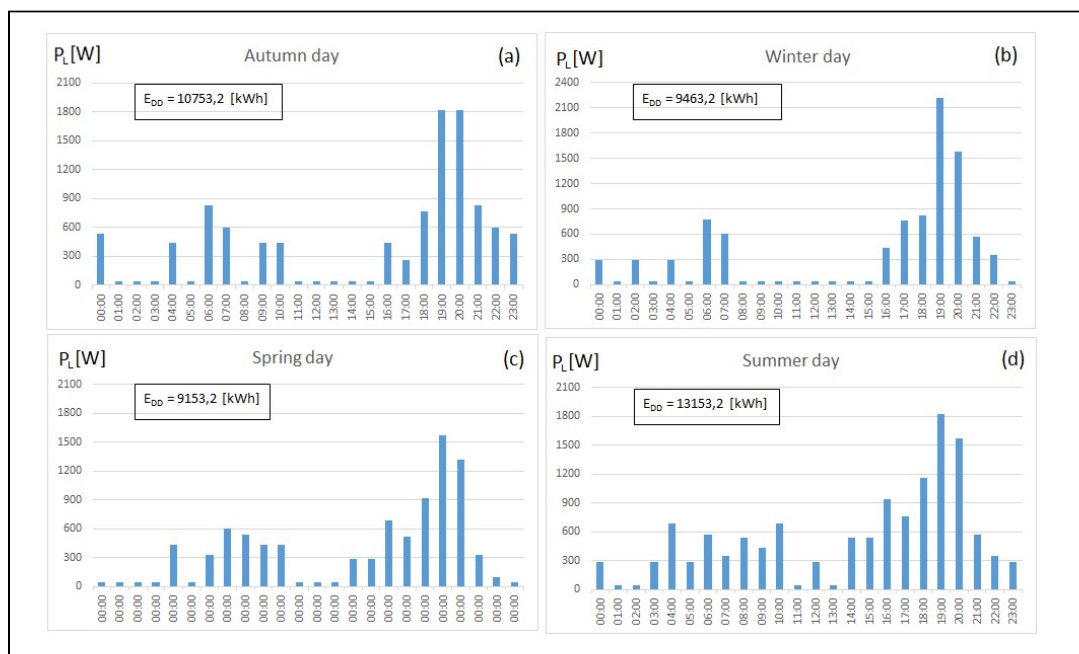
Figure 3. The energy demand proposed for each season: ( a ) Autumn, ( b ) Winter, ( c ) Spring, ( d ) Summer.